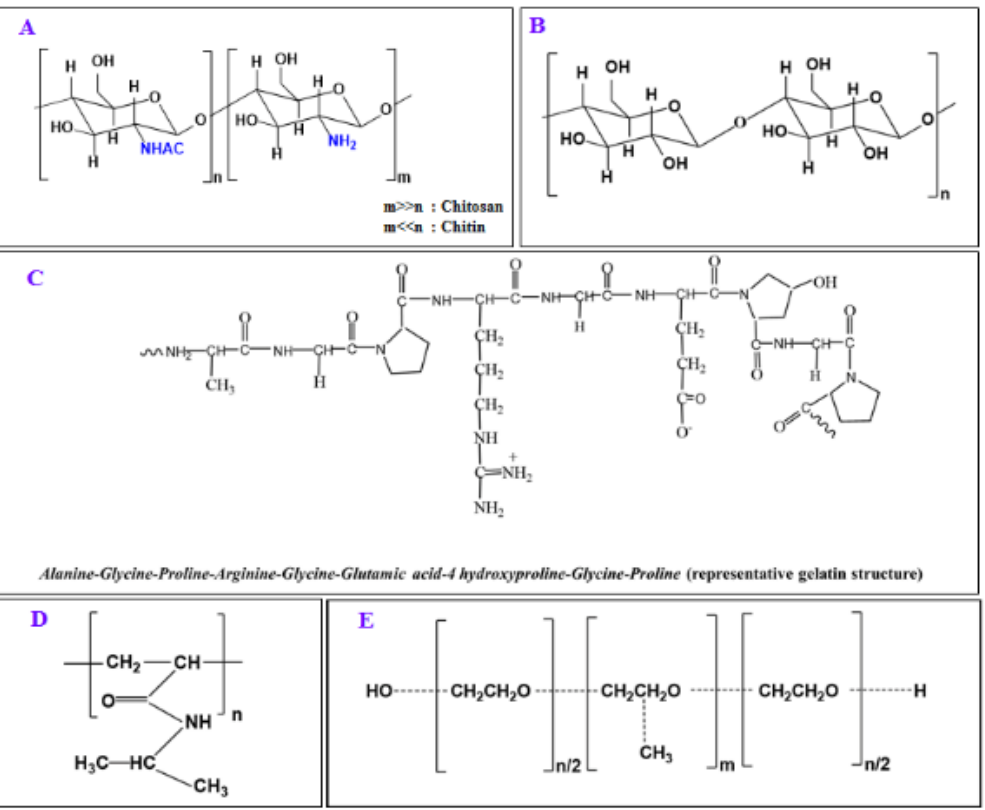
Figure 2. Chemical structure of chitosan ( A ); cellulose ( B ); gelatin ( C ); pNIPAAm ( D ); PF127 ( E ).